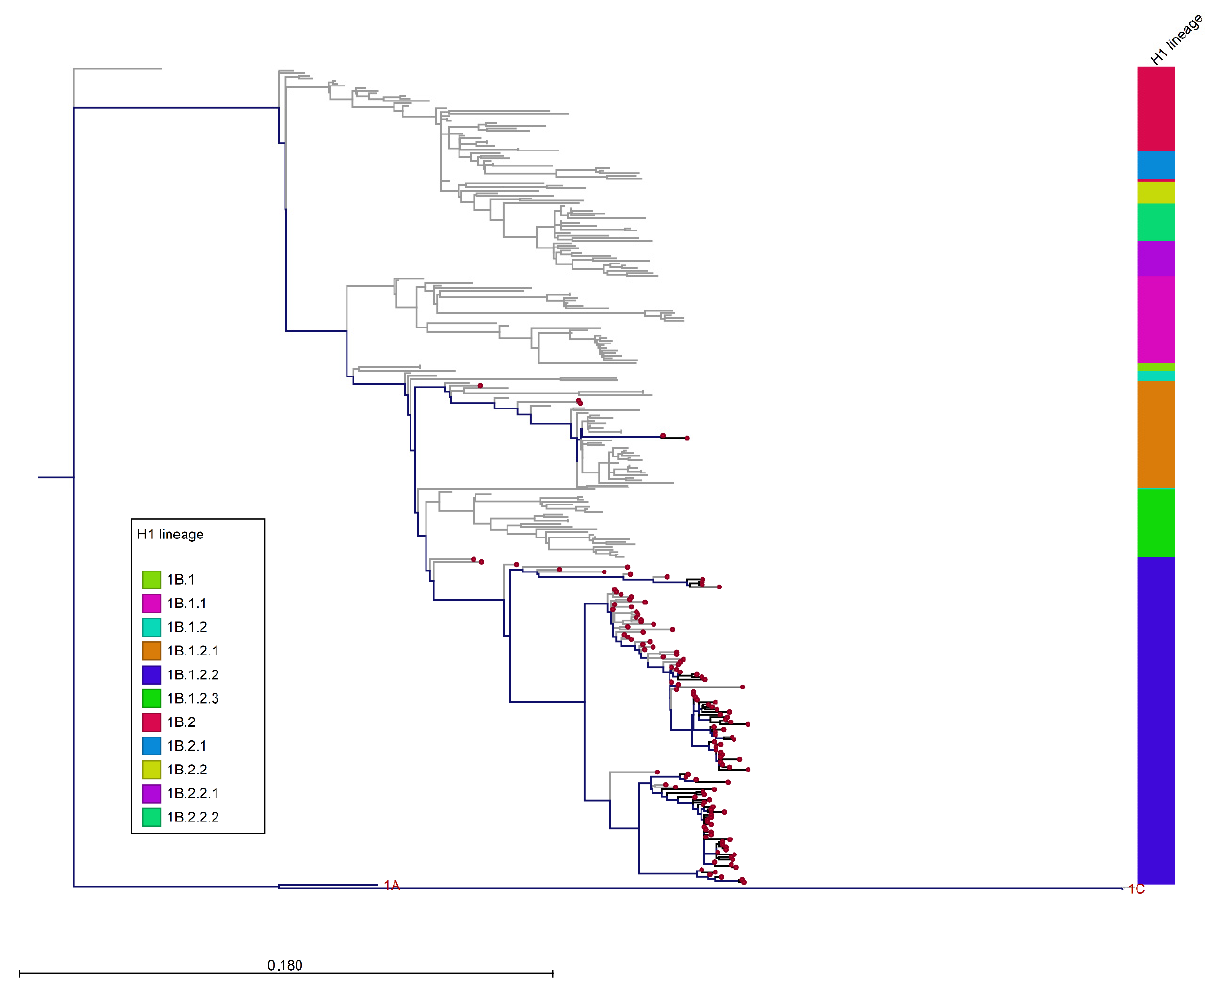
Figure 5. ML phylogenetic tree of 1460 HA-H1 sequences ( n = 270 HA-1A, n = 322 HA-1B, and n = 857 HA-1C) with the 86 HA-1B sequences (1611 nucleotides) of strains analyzed in this work inferred with swine references sequences retrieved from Genbank. Scale bar represents number of nucleotide substitutions per nucleotide site. Tree visualized using CLC genomic workbench v.11. To simplify visualization, HA-1A and HA-1C branches have been collapsed. The Italian sequences are represented by red dots; the bar colors distinguish HA-1B clusters. Branch colors distinguish strains collected before 2017 (grey) or after 2017